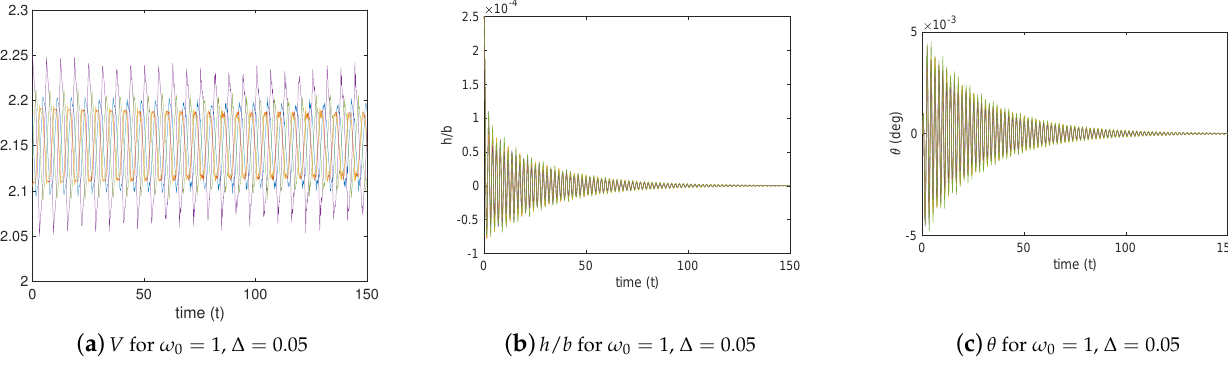
Figure 16. Oscillation of the airfoil with correlation function, r xx = Cos ( ω 0 τ ) , where ω 0 = 1, ∆ = 0.05, and V ave = 2.15.